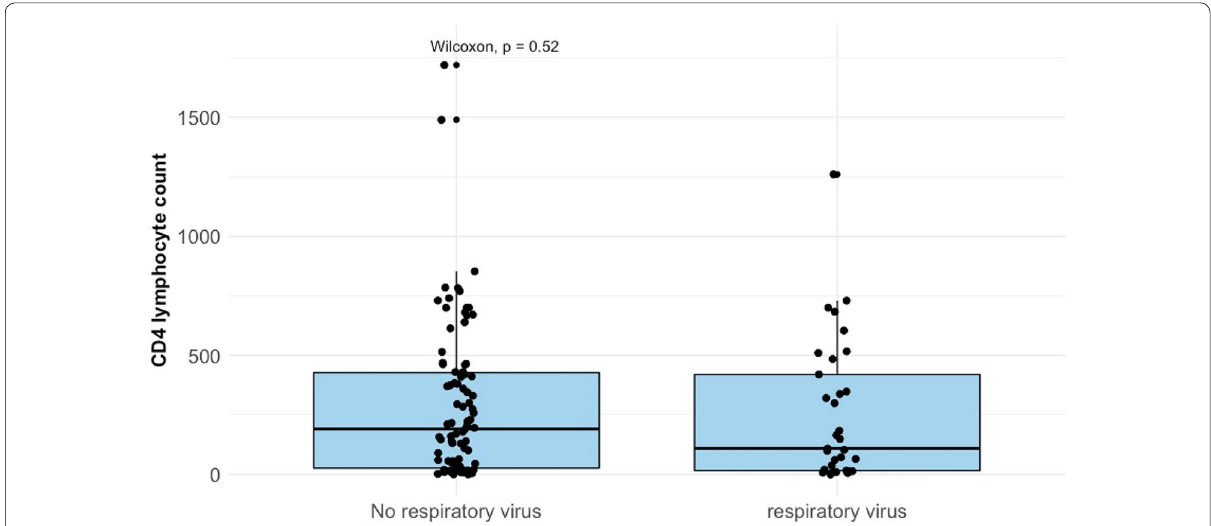
Fig. 1 Diagnosis of respiratory virus‑associated infection according to the CD4 lymphocyte count on the ICU